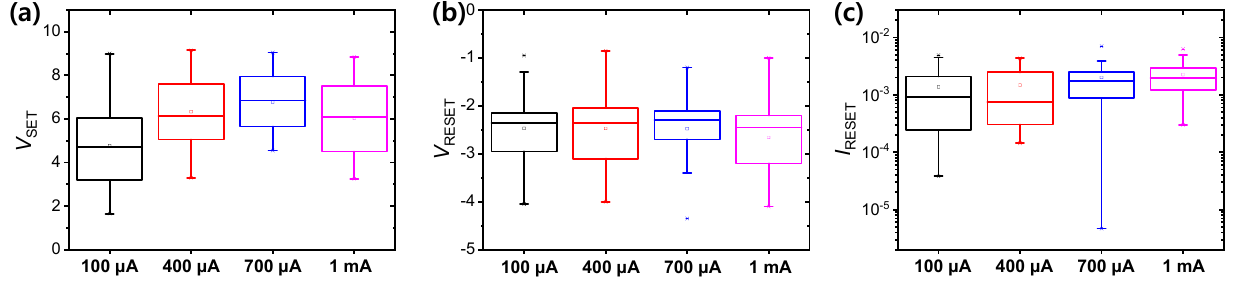
Figure 3. ( a ) Set voltage, ( b ) reset voltage, and ( c ) reset current distributions of Au/Ti/HfTiO x /p-Si device. Figure 4 shows the retention property of the Au/Ti/HfTiO x /p-Si device in the LRS and HRS. The LRS and HRS were extracted at a read voltage of 0.5 V. Two states did not change significantly for 10,000 s, indicating this device has nonvolatile memory.